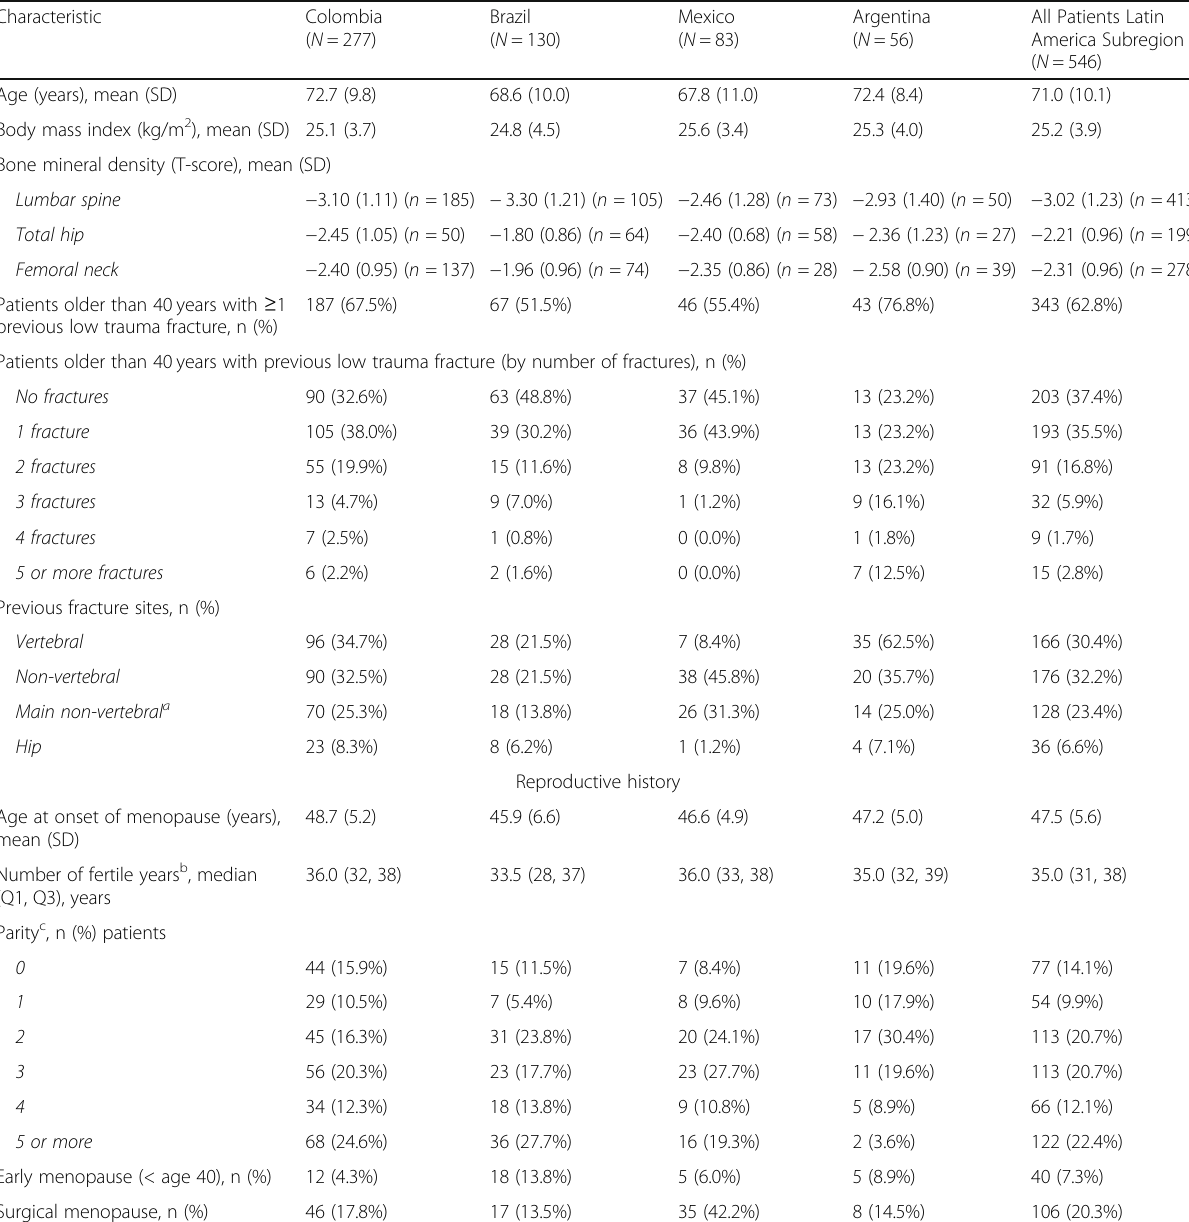
Table 1 Baseline characteristics and reproductive history